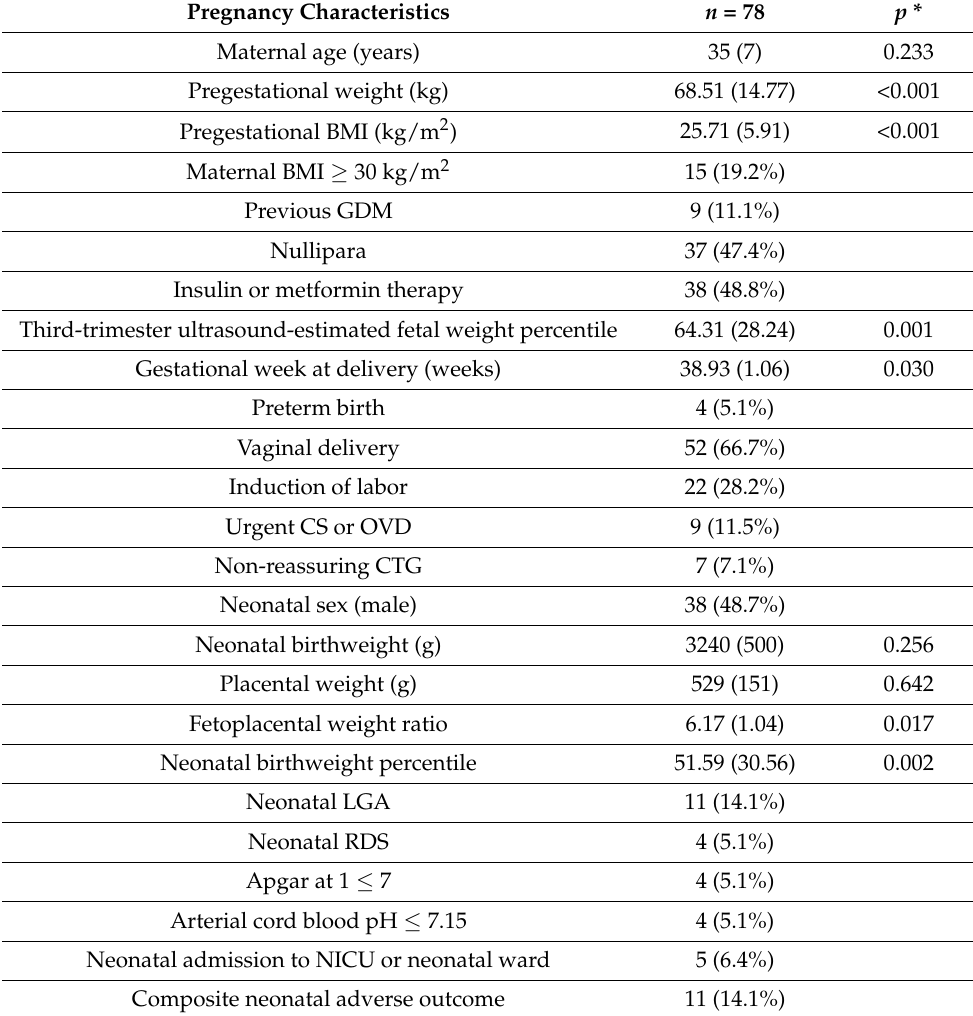
Table 1. Maternal, obstetric, and neonatal characteristics of included women.